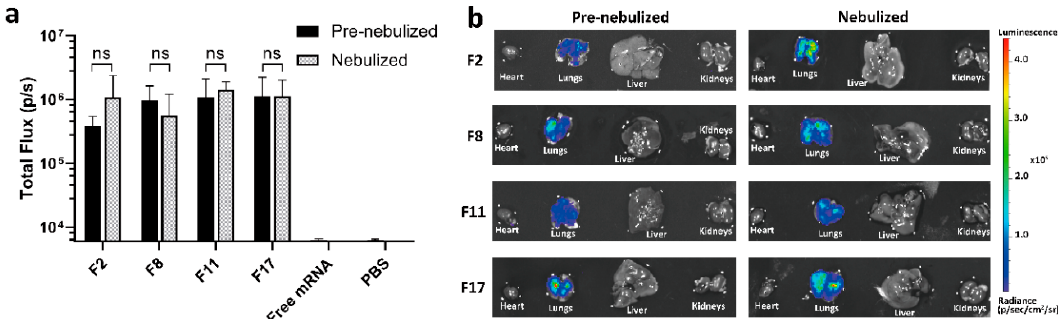
Figure 4. Delivery e ffi cacy of F2, F8, F11, F17 formulations with luciferase mRNA. ( a ) E ffi cacy of the four lead formulations before and after nebulization in lung as measured in total flux of luminescence 6 h after intratracheal delivery of 1.5 µ g of total mRNA. ( b ) Representative images of the luciferase expression in the lungs, heart, liver, and kidneys measured by in vivo imaging system (IVIS)